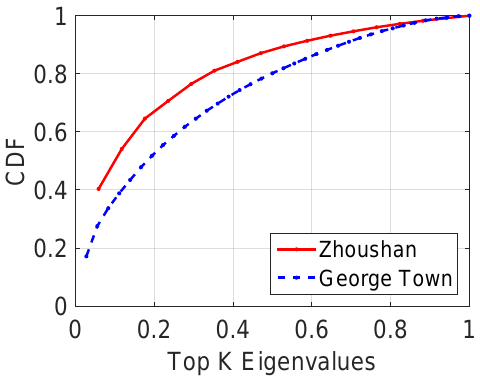
Figure 3. Top k Eigenvalues in George Town and